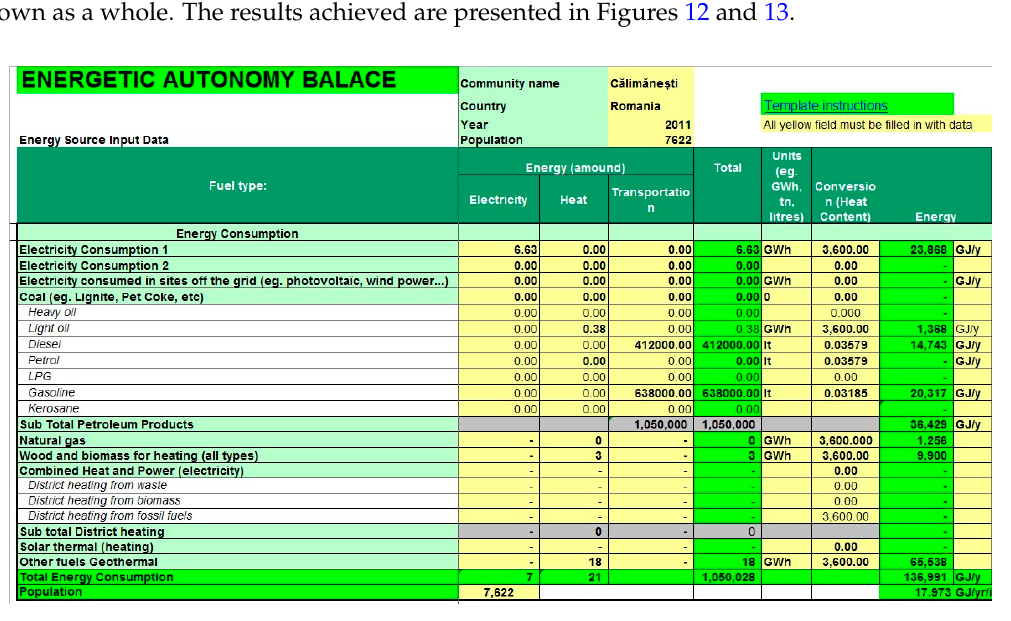
Figure 13. Energy production and the autonomy rate of C ă lim ă ne ș ti.